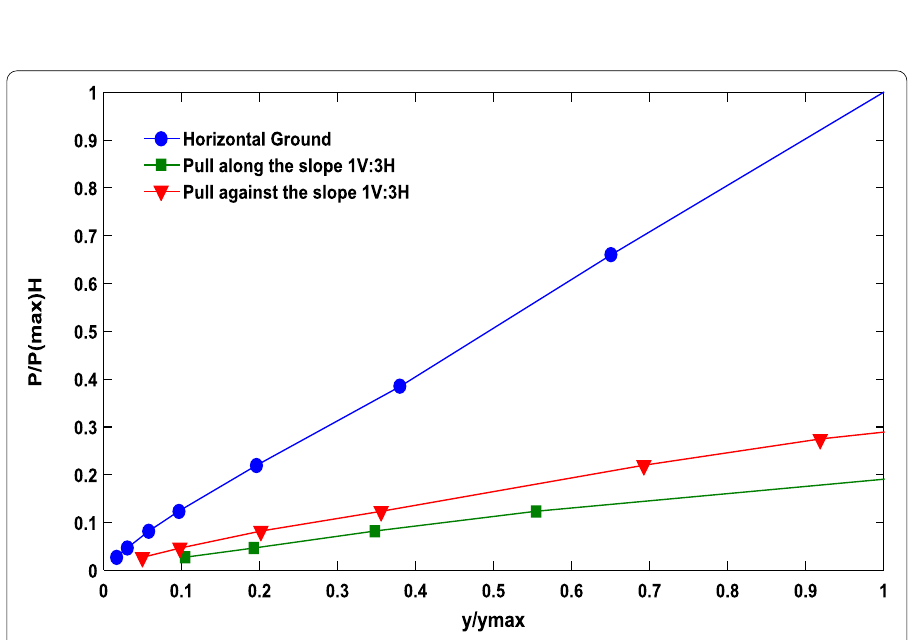
Fig. 11 Comparison of lateral load capacity between horizontal and sloping 1V: 3H